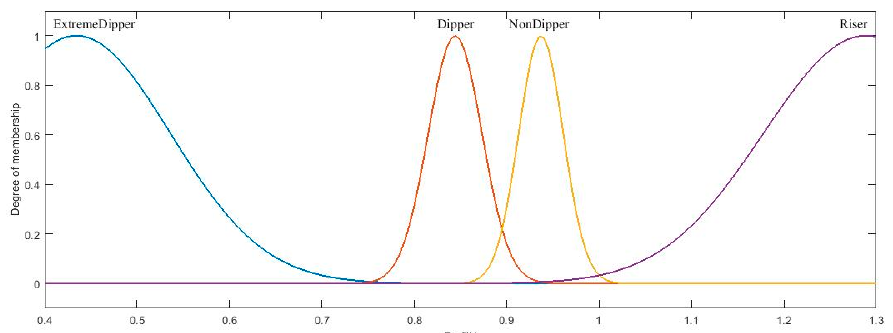
Figure 23. Optimized nocturnal blood pressure level output.